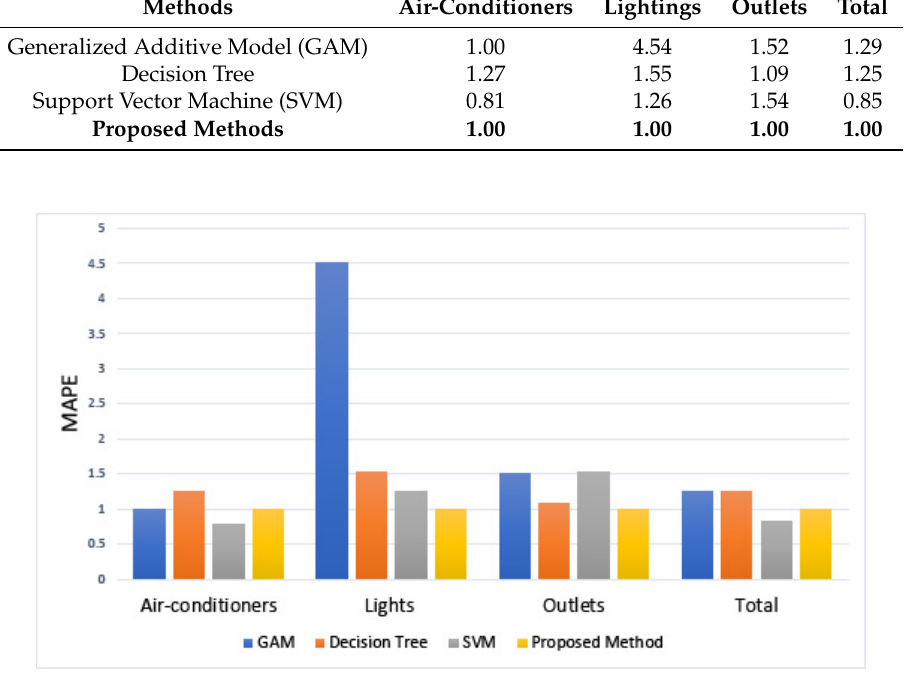
Figure 15. Results of prediction accuracies for prediction